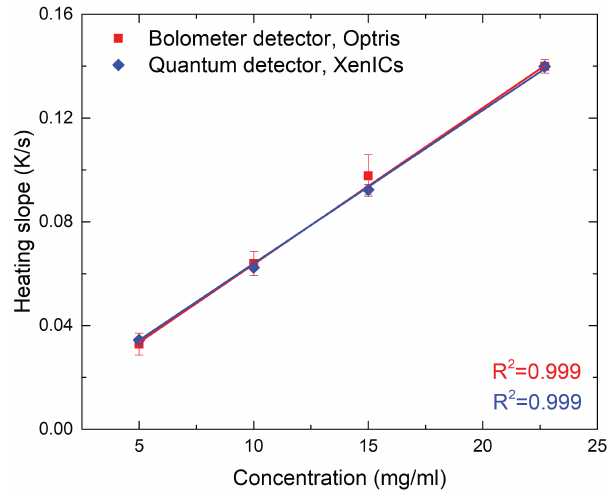
Figure 9. Comparison of LIT thermal investigations on 21 nm SPIONs using a microbolometer sensor (PI-460, Optris, Berlin, Germany) and a quantum sensor (Onca-MWIR-InSb-320, XenICs, Leuven, Belgium) (triplicate experiment). Solid lines show best fit linear regression curves through the data. To compensate for the lower sensitivity of the microbolometer sensor, measurement times were adjusted, i.e., 30 s and 500 s were set for the Onca camera and the PI-460,